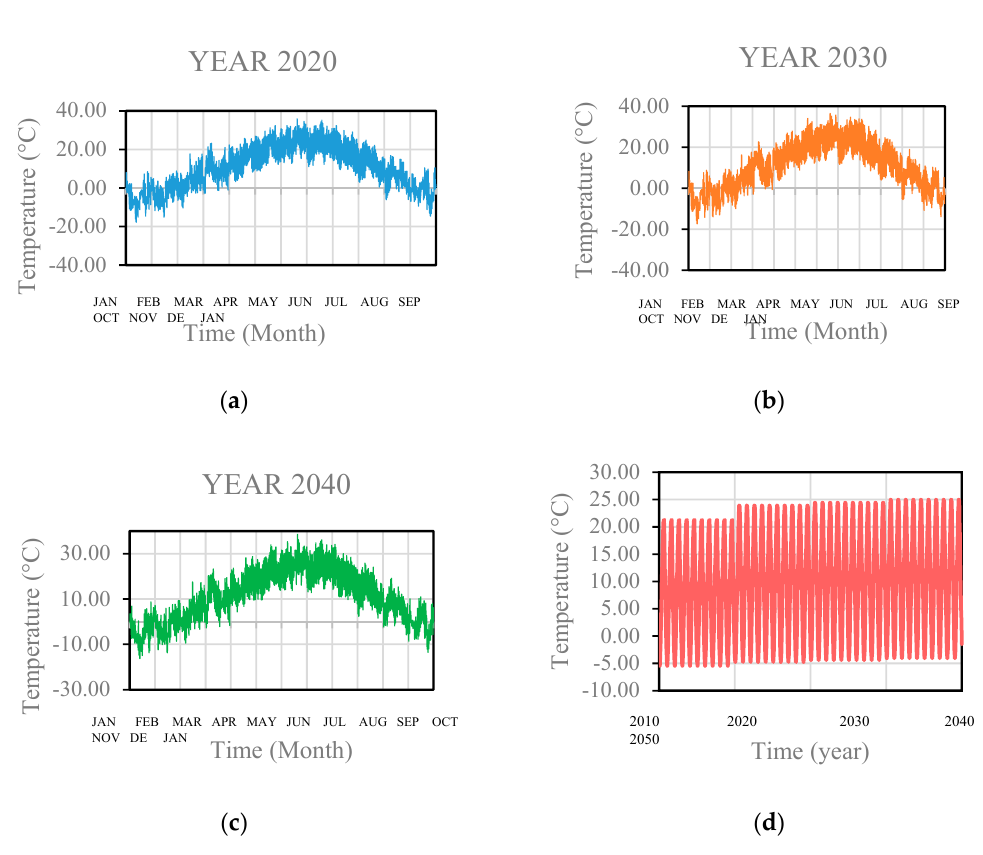
Figure 5. Future ambient temperature projection of Qinarjeh village for ( a ) year 2020; ( b ) year 2030; ( c ) year 2040; and ( d ) future average monthly ambient temperature projection of Qinarjeh village until the 2050 s.